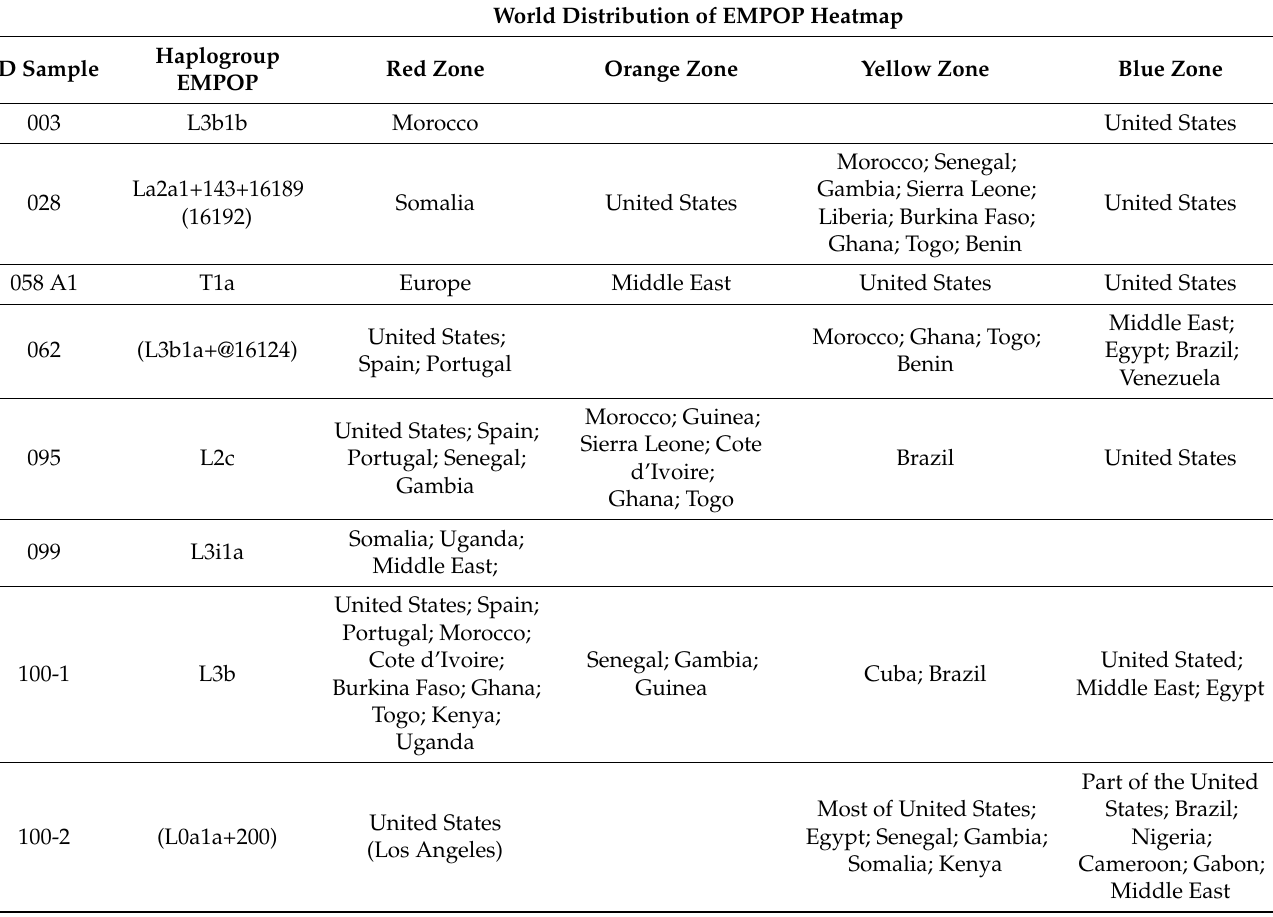
Table 6. Sample ID, haplogroup according to EMPOP nomenclature, worldwide distribution of haplogroups observed from heatmaps. Red zone refers to a major presence of the haplogroup, orange to an intermediate presence, yellow to a minor presence, and blue to a very low presence. World Distribution of EMPOP